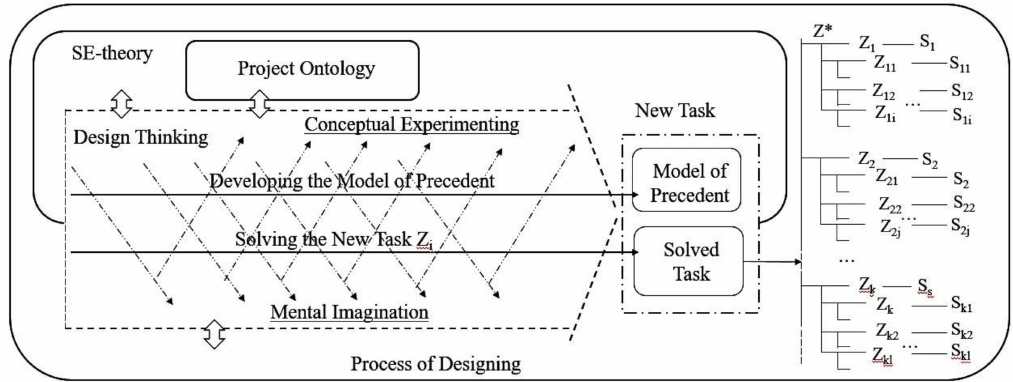
Figure 17. The context of design